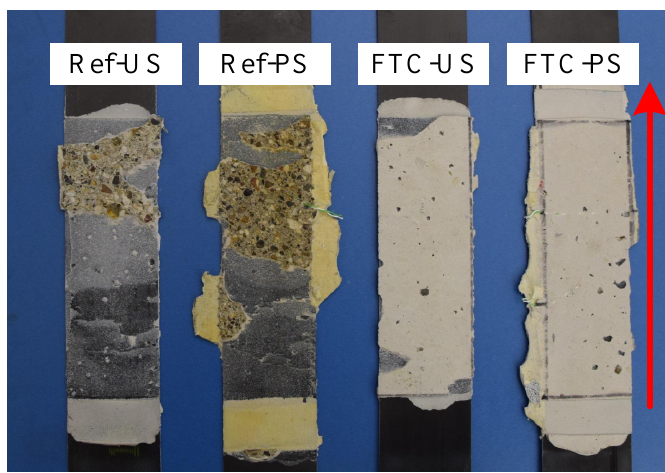
Figure 11. One sample from each case demonstrating the shift in the failure mode from a concrete- substrate to an epoxy-concrete interface